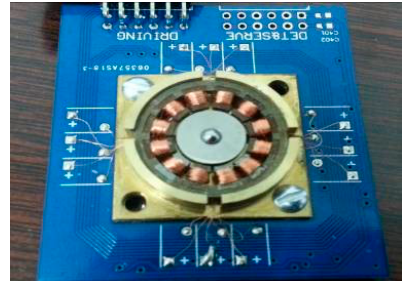
Figure 1. Mechanical structure of micro gyroscope with ball-disc rotor